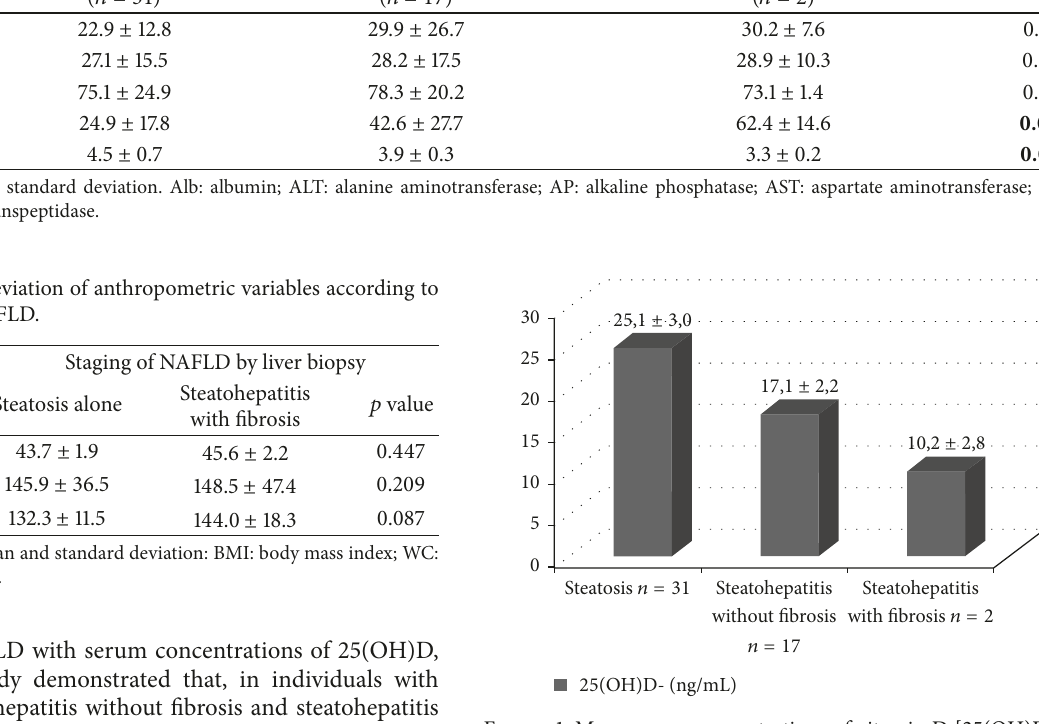
Figure 1: Mean serum concentrations of vitamin D [25(OH)D] by staging of NAFLD by liver biopsy. ANOVA ( 𝑝 < 0 , 01